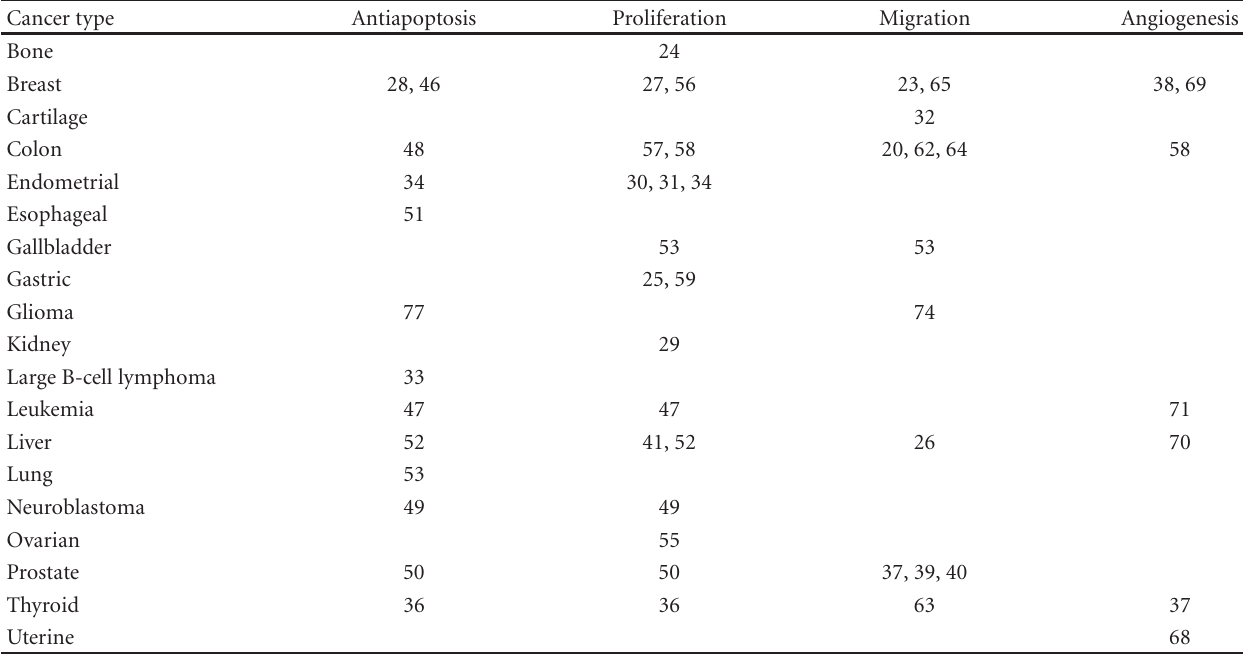
Figure 1: Cellular pathways activated through leptin receptor (ObR) stimulation. Table 1: Summary of the Literature: leptin’s role in cancer promotion ∗